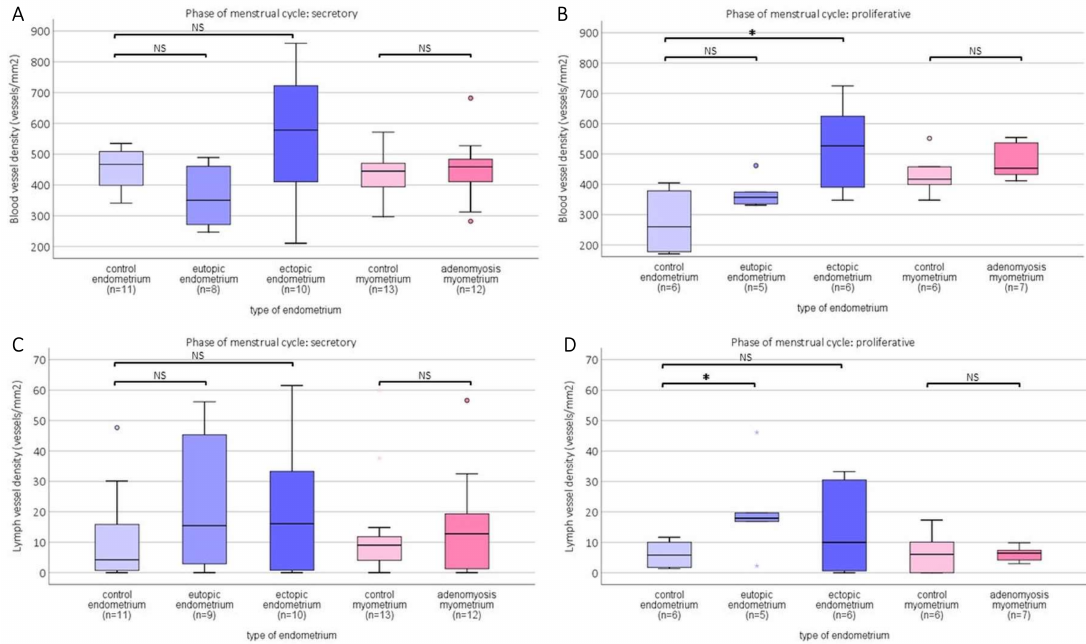
Figure 6. Top row: Boxplots of blood vessel density (BVD) determined by the count of CD31 stained area (vessels) per mm 2 in the secretory phase ( A ) and proliferative phase ( B ) of the menstrual cycle per tissue type. In the secretory phase, there were no significant differences in BVD between tissue types. In the proliferative phase, the BVD was significantly higher in the ectopic endometrium than in the control endometrium ( p < 0.05). Bottom row: Boxplots of lymph vessel density (LVD) determined by the count of podoplanin stained area (vessels) per mm 2 in the secretory phase ( C ) and proliferative phase ( D ) of the menstrual cycle per tissue type. In the secretory phase, there were no significant differences in LVD between tissue types. In the proliferative phase, the LVD was significantly higher in the eutopic endometrium than in the control endometrium ( p < 0.05). Data shown as median ± range. NS: not significant; * significance p <